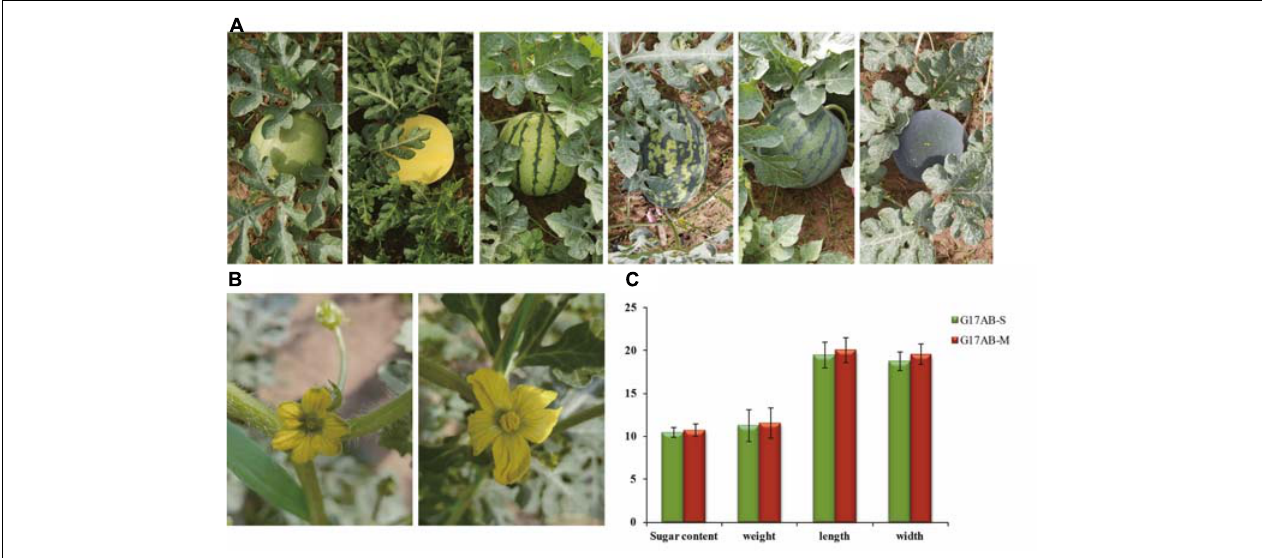
FIGURE 1 | Comparison of the male flowers and fruits between male-sterile and male-fertile watermelon plants. (A) Different inbred lines (from left to right : “Cai1,” “Cai7,” “Kexi,” “Juwang,” “Tianli,” and “Changhei”). (B) Comparison of the flowers from male-sterile ( left ) and male-fertile ( right ) G17AB watermelon plants. (C) The sugar content, weight, length, and width of individual fruits from the male-fertile and male-sterile G17AB watermelon